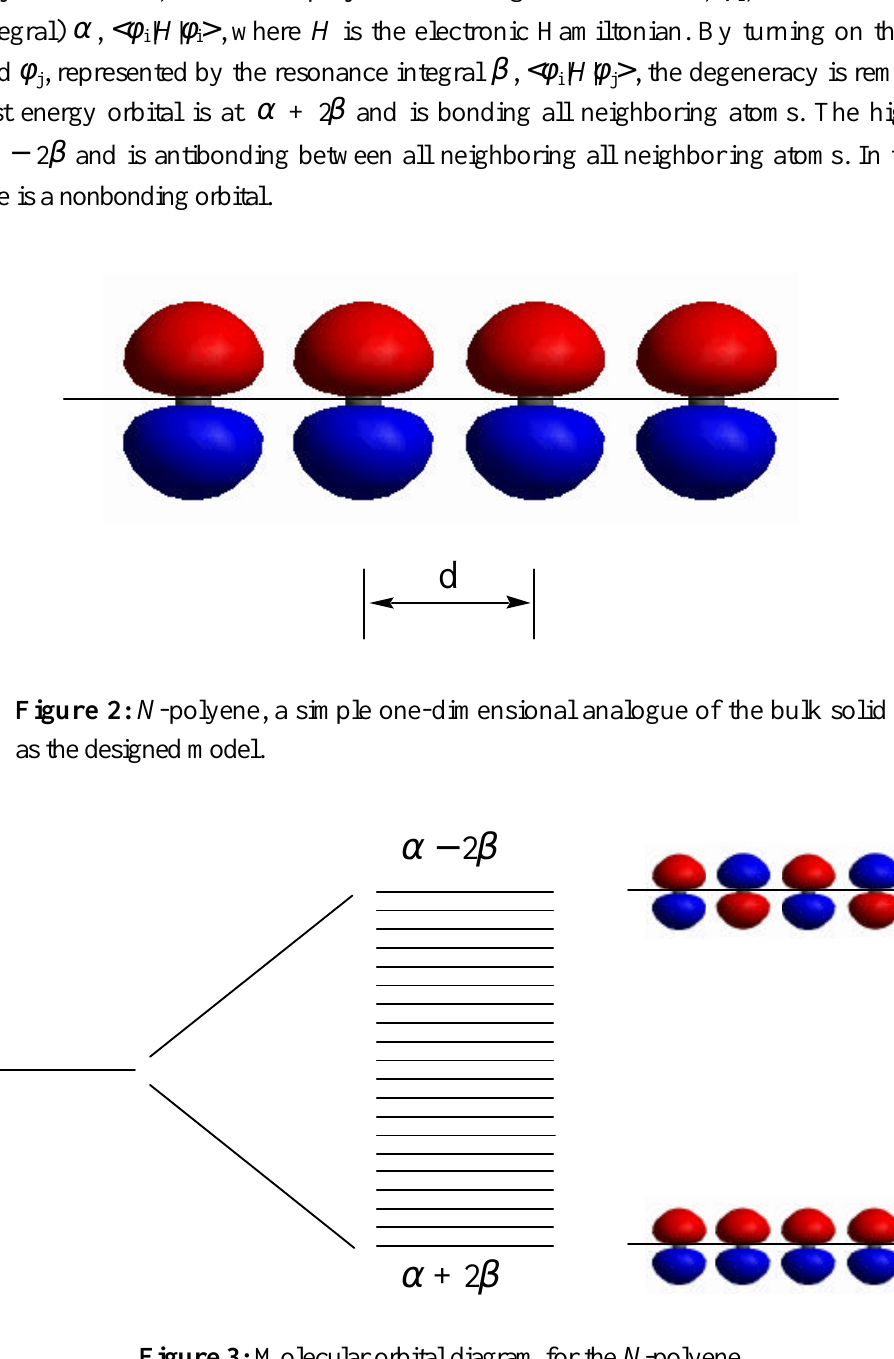
Figure 3: Molecular orbital diagram for the N